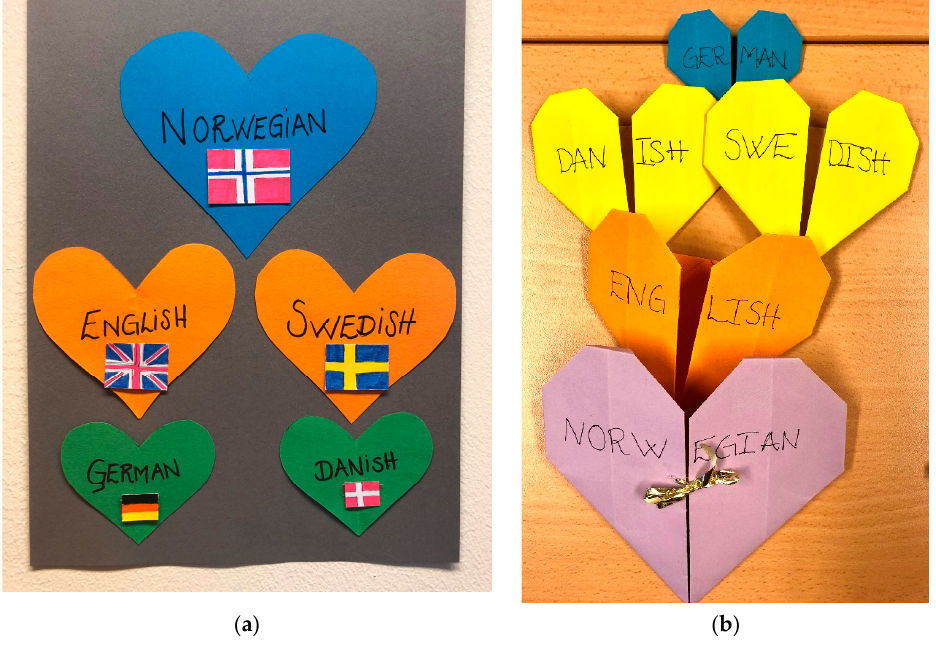
Figure 6. ST6’s ( a ) and ST7’s ( b ) DLC artefacts. ST7 created a similar structure, origami nested hearts, also in different colours and sizes in four rows, with English occupying the second row on its own. The other lan- guages, Swedish and Danish (third row) and German (fourth row) represent languages that the ST may have understood but did not speak. In the ST’s words, ‘I wanted them to be in different sizes because of how well I know and understand the languages. The